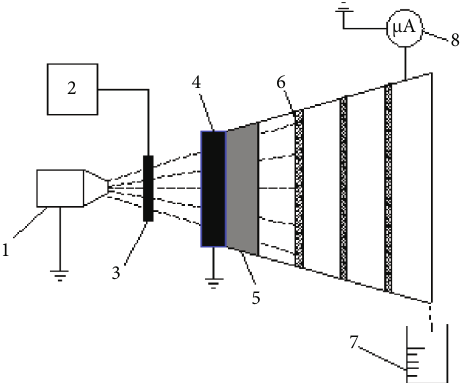
Figure 3: Measurement device of charge-mass ratio: 1. atomizing nozzle; 2. negative high-voltage power source; 3. burr electrode; 4. induction shield ring; 5. insulation layer; 6. metal mesh; 7. water droplet collector; and 8.precision micro